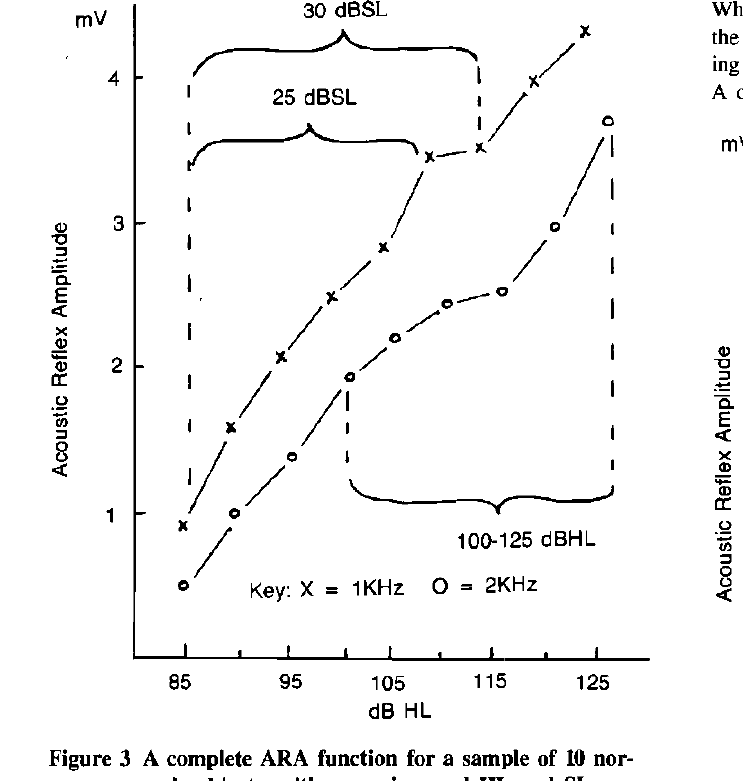
Figure 3 A complete ARA function for a sample of 10 nor- mal subjects, with super imposed HL and SL ranges, at IKHz and 2KHz at 2KHz was reduced relative to the HL value, indicating an asymp- totic function.